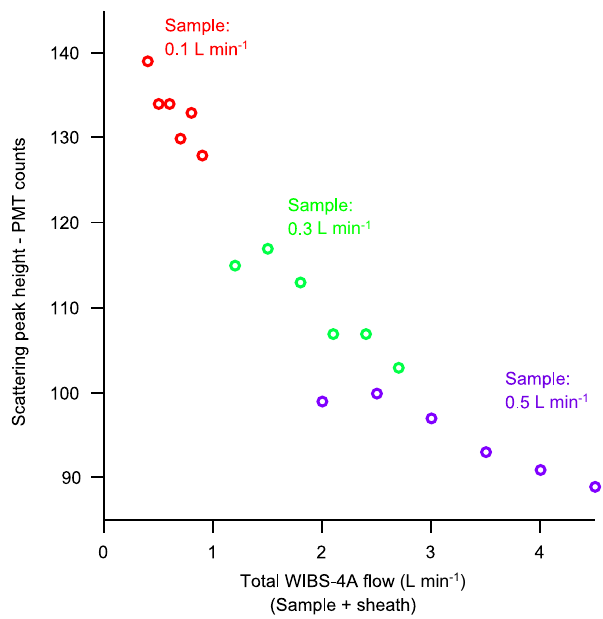
Figure 1. Scattering signal dependence on total WIBS flow rate (sample + sheath) in Lmin − 1 . Data collected at a given sample flow rate are colored similarly. All data shown are for 1100nm dioctyl sebacate